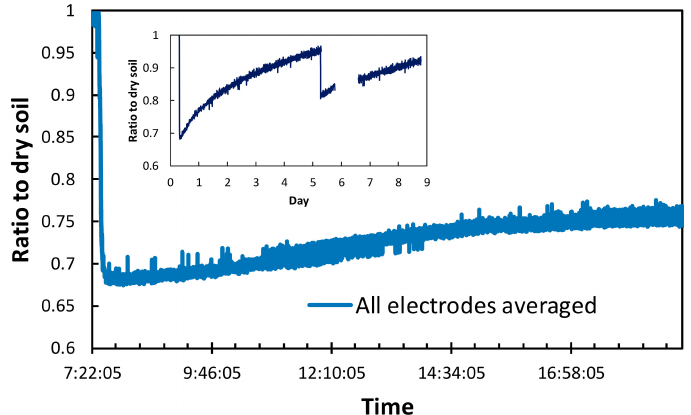
Figure 11. The average relative resistance values measured by all pairs of electrodes as a function of time. As soil dried, the measured resistance values gradually increased toward the values of a dry soil. The insert shows the recovery of soil resistance during drying over a period of several days, in between two consecutive applications of